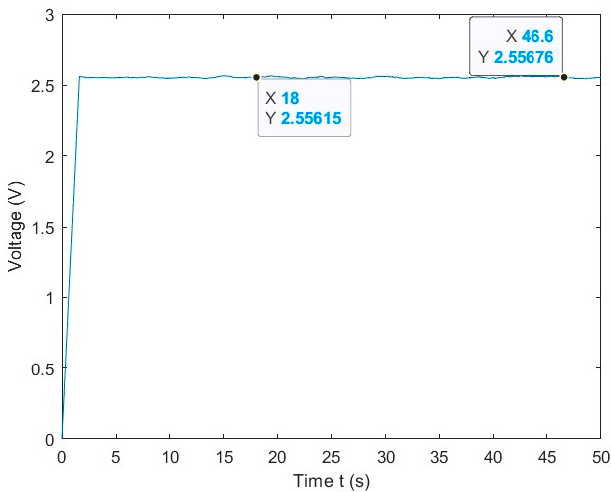
Figure 18. Simulink model for signal reading using the 16-bit ADC.